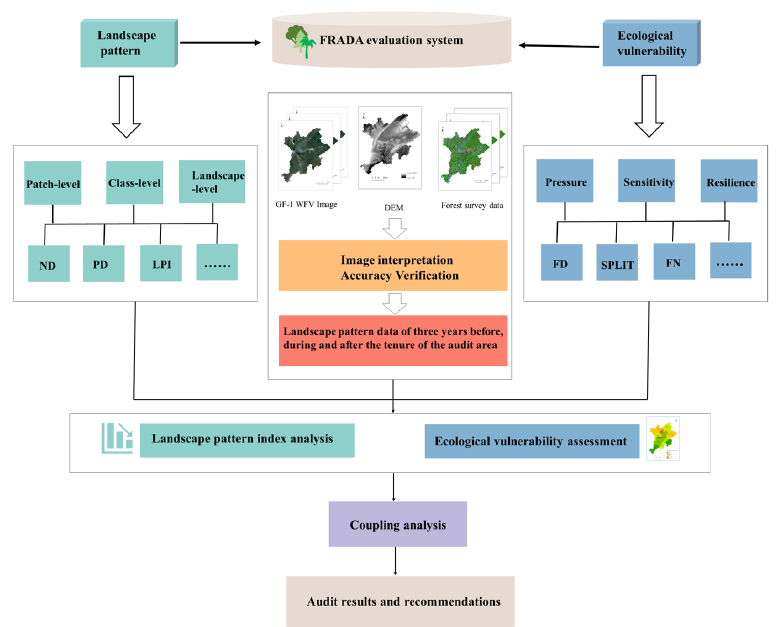
Figure 2. Research